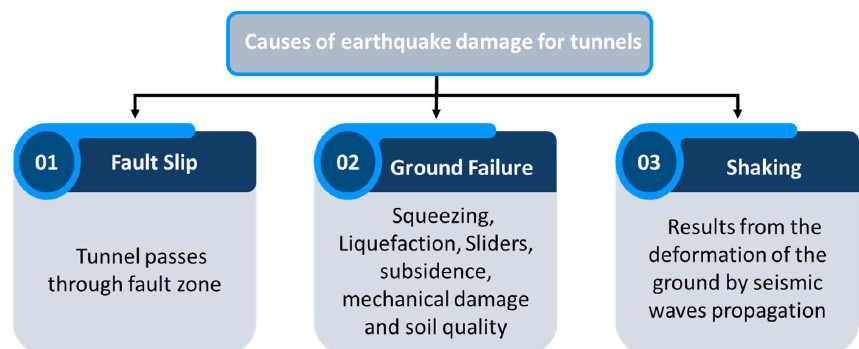
Figure 2. Causes of earthquake damage to tunnels.